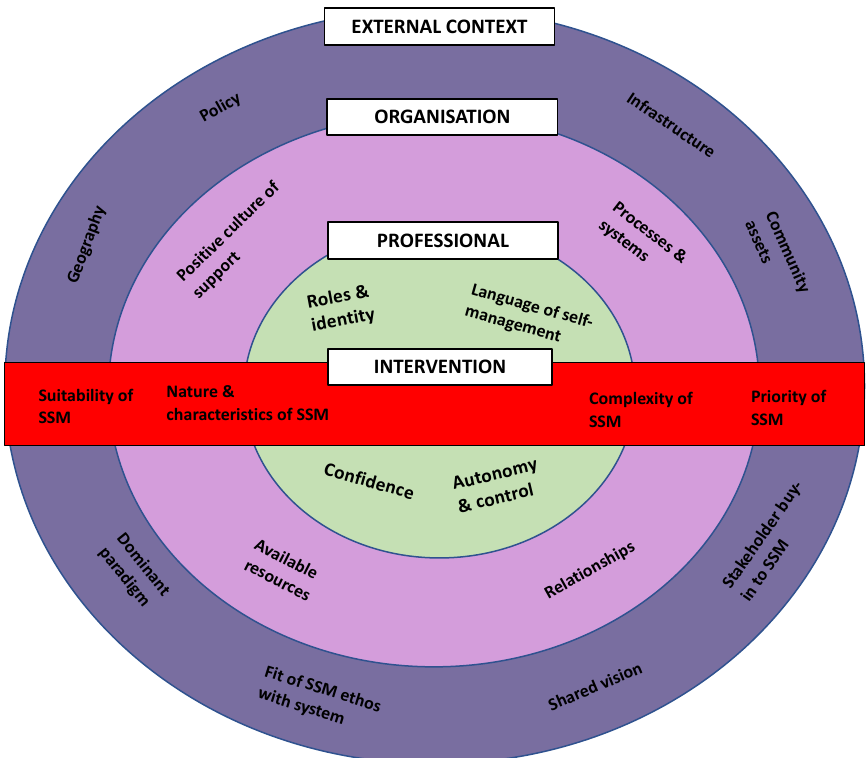
Figure 1. Conceptual framework describing key elements that influence the implementation of change in primary care (Lau et al., 2016)